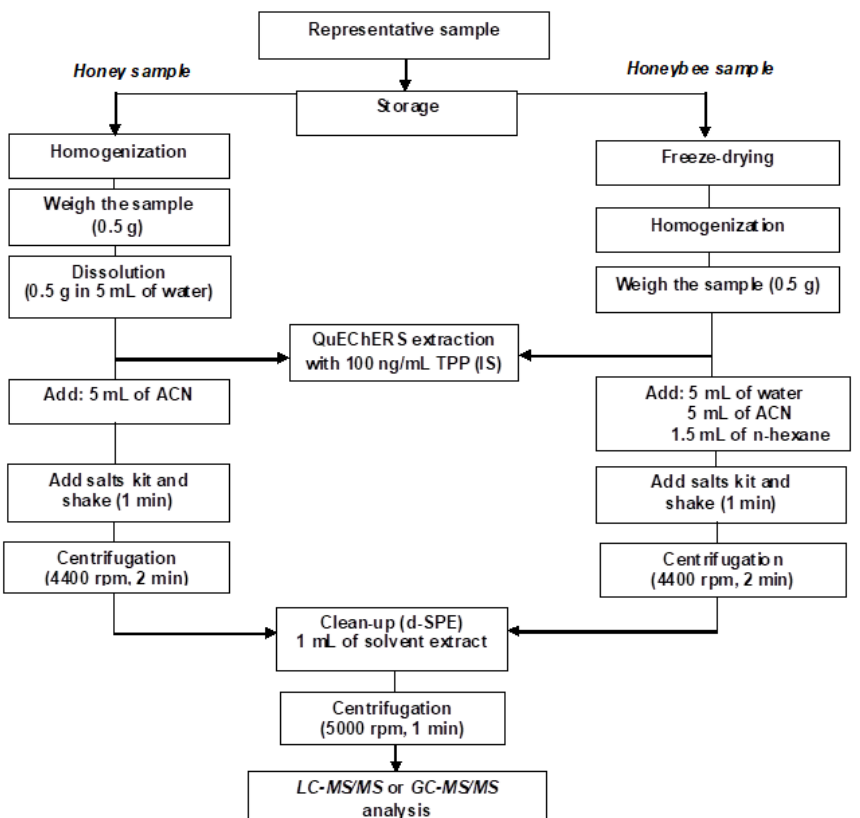
Figure 5. Scheme of pesticide extraction procedures from honey and honeybee samples using the QuEChERS extraction before final analysis.